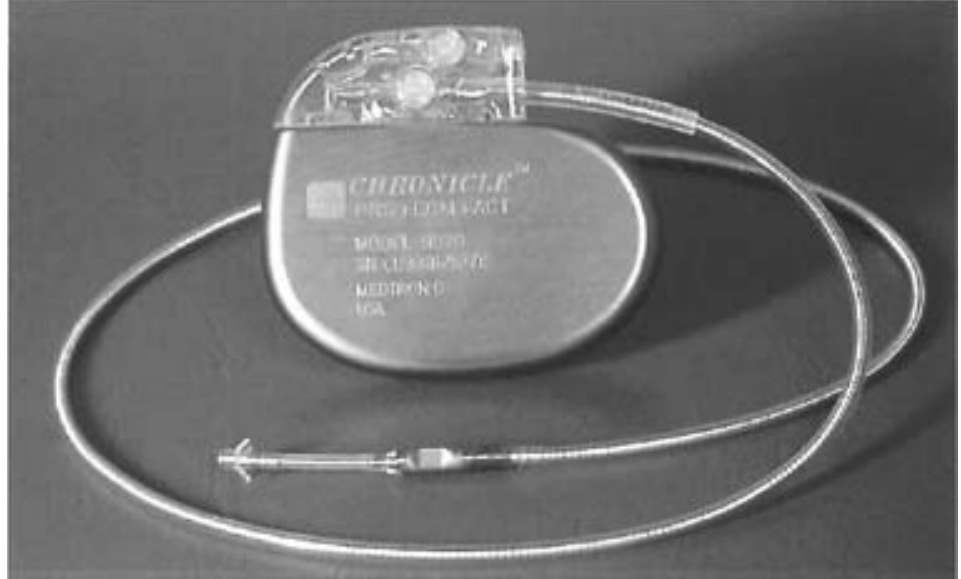
Figure 4. The Chronicle implantable hemodynamic monitoring (IHM) system with a pressure transducer incorporated near the tip of a right ventricular (RV) lead. Reprinted from Journal of Cardiac Failure, Volume 8, Issue 2, Magalski et al., Continuous ambulatory right heart pressure measurements with an implantable hemodynamic monitor: A multicenter, 12-month follow-up study of patients with chronic heart failure, Pages 63–70, Copyright 2002, with permission from Elsevier [17].